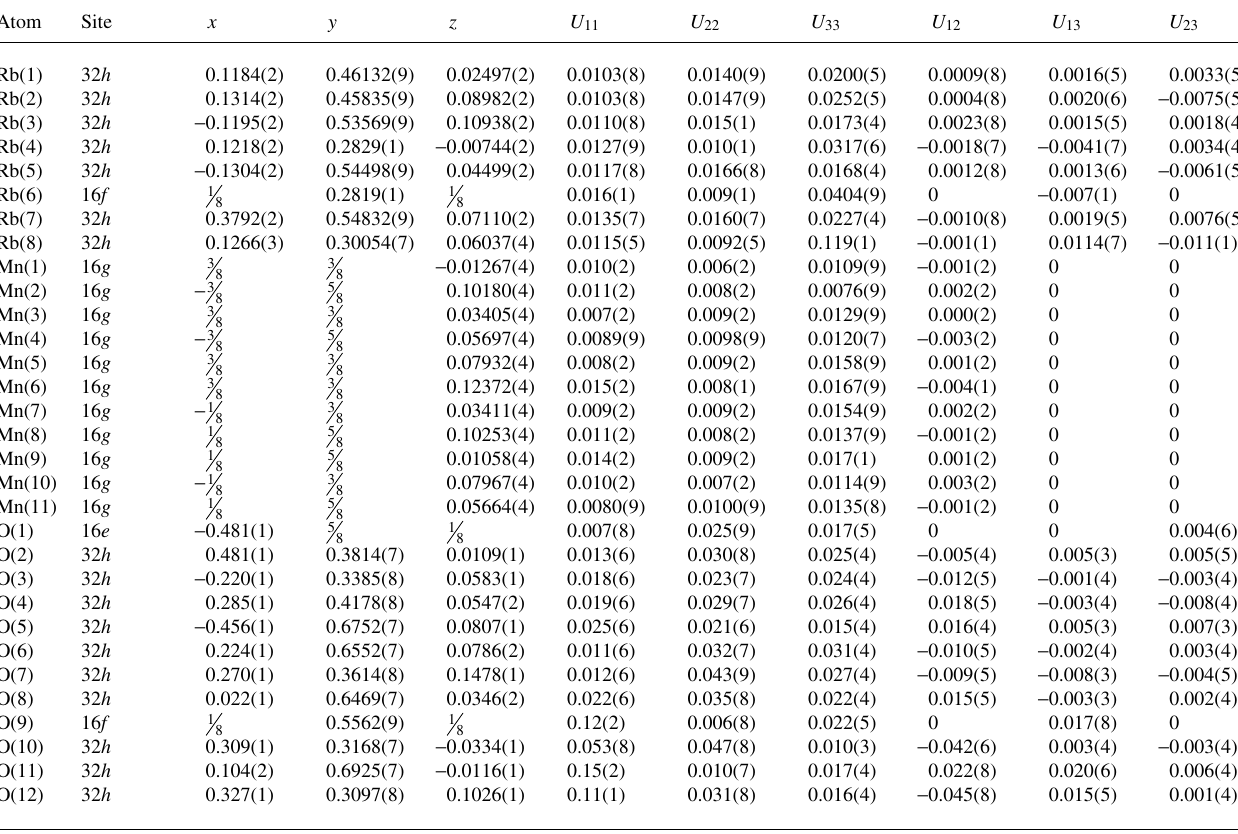
Table 2. Atomic coordinates and displacement parameters (in Å 2 )